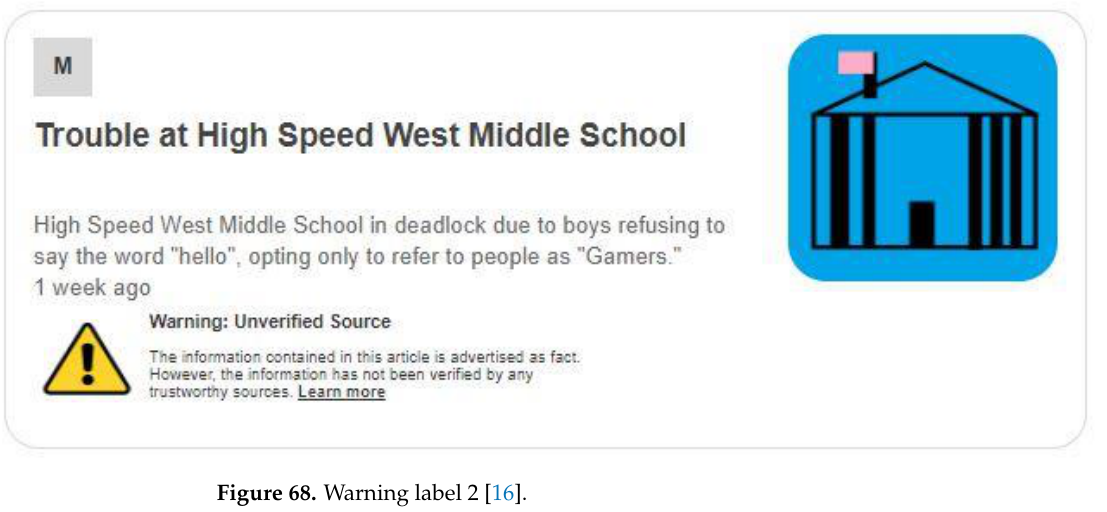
Figure 68. Warning label 2 [16].